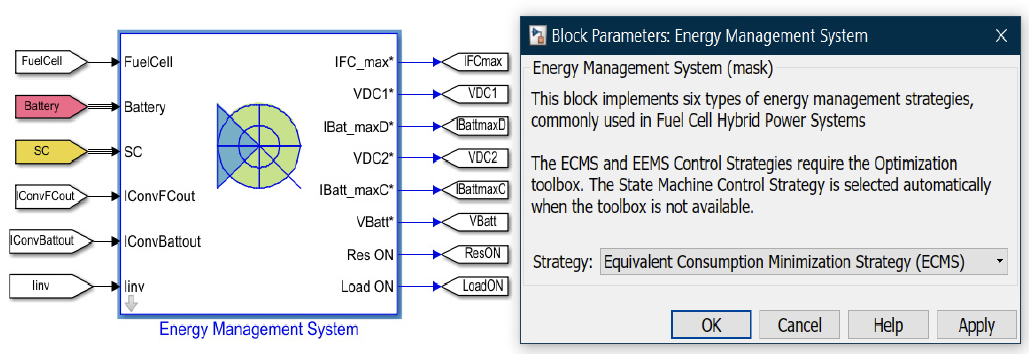
Figure A7. EMS—Equivalent Consumption Minimization Strategy setup.